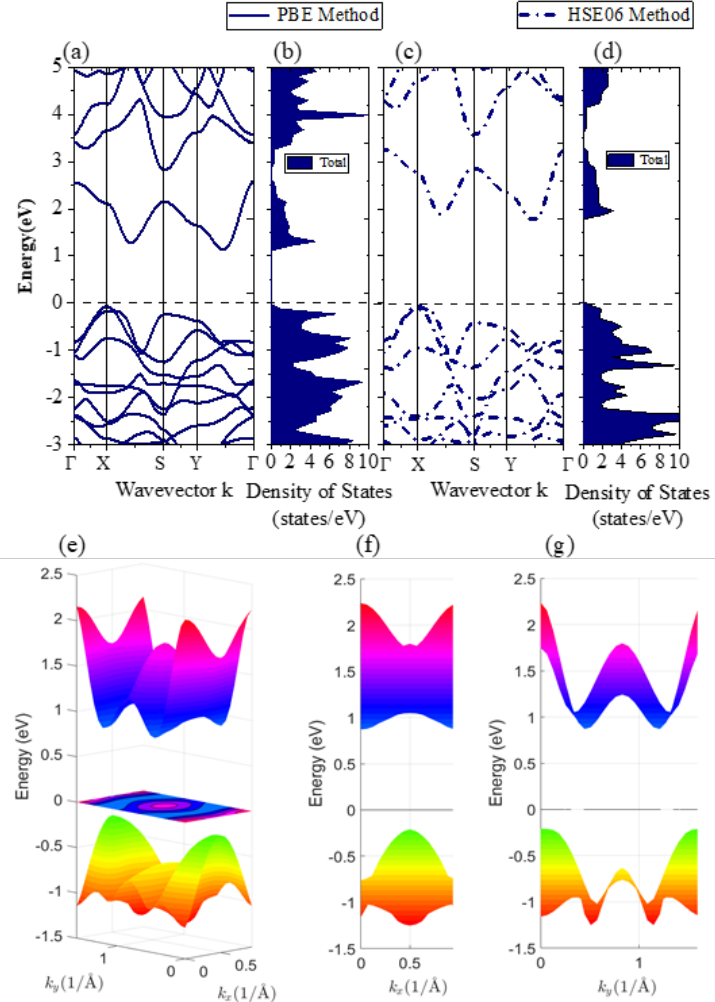
Figure 2. ( a , c ) The band structure of the monolayer β -AuSe using the PBE method and HSE06 method, respectively. ( b , d ) The density of states of the monolayer β -AuSe using the PBE method and HSE06 method, respectively. ( e – g ) The 3D band structure for the monolayer β -AuSe in different